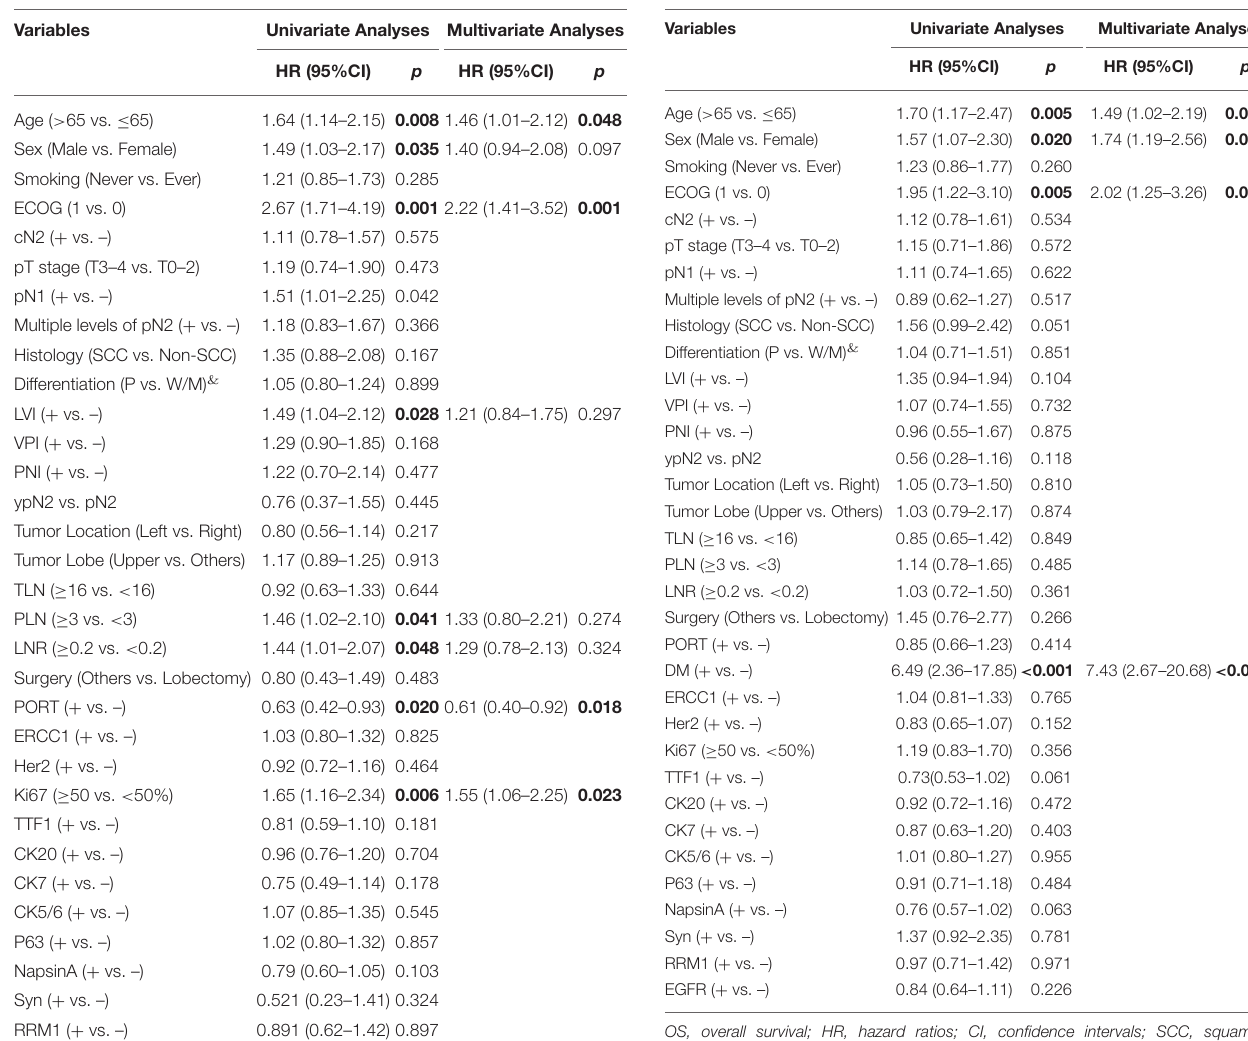
TABLE 4 | Cox analyses of clinical-pathological variables associated with OS2 in patients with recurrent